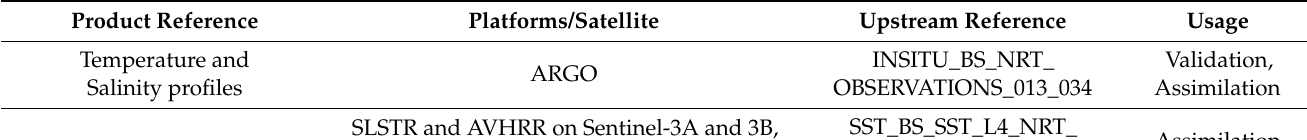
Table 1. List of observations used by BSFS in the assimilation and verification